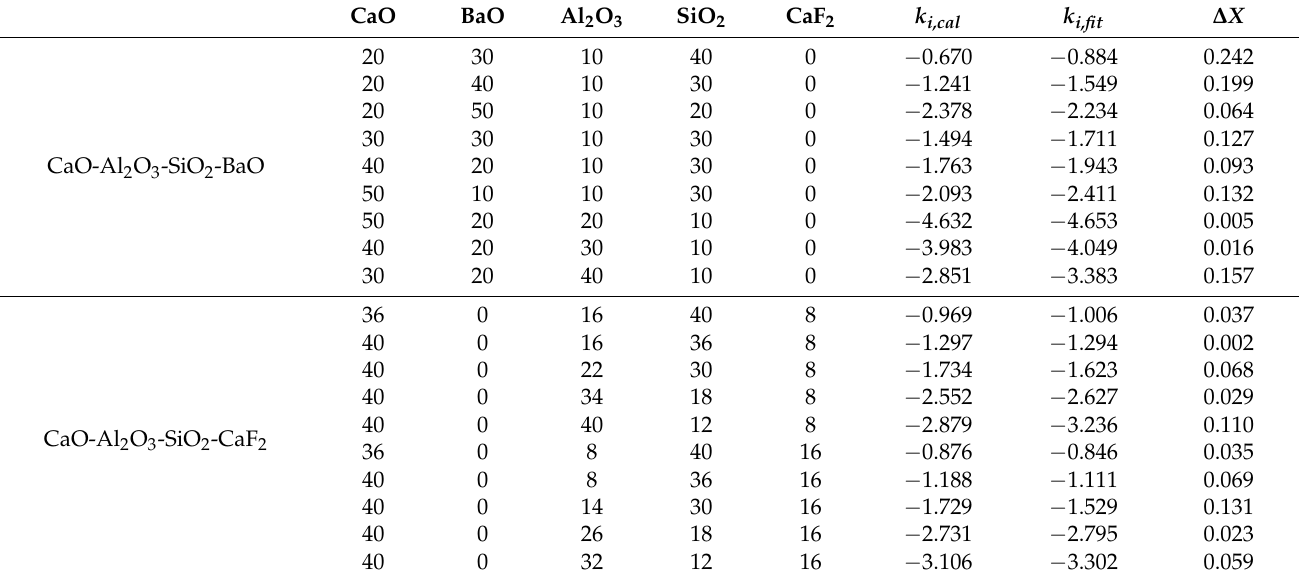
Table 4. Composition of the CaO-Al 2 O 3 -SiO 2 -BaO/CaF 2 quaternary flux system (wt%) and activity of SiO 2 .